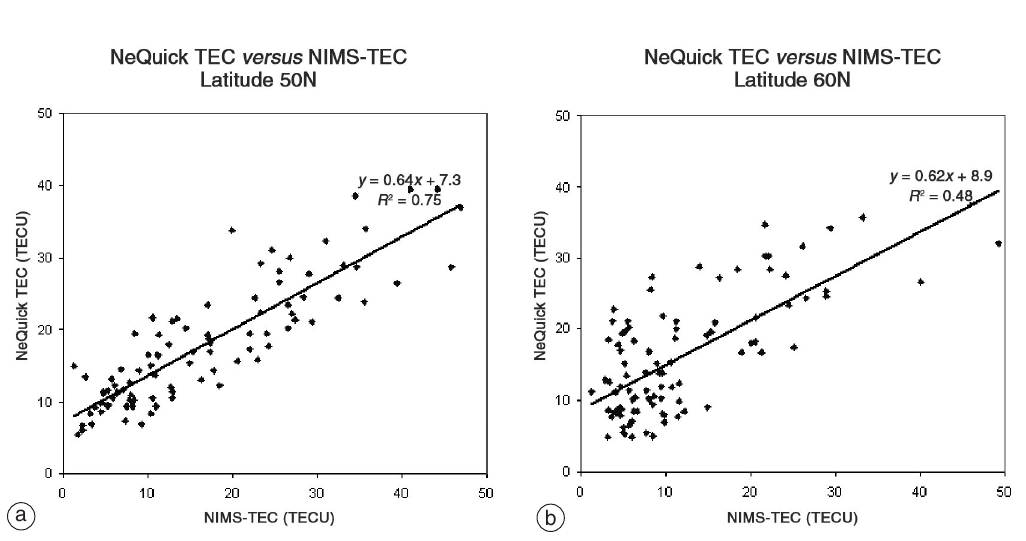
Fig. 8.12. Comparison of TEC up to 1000 km estimated by the NeQuick model with experimental measure- ments obtained from observations of NIMS satellites in U.K. for latitudes of (a) 50°N and (b)